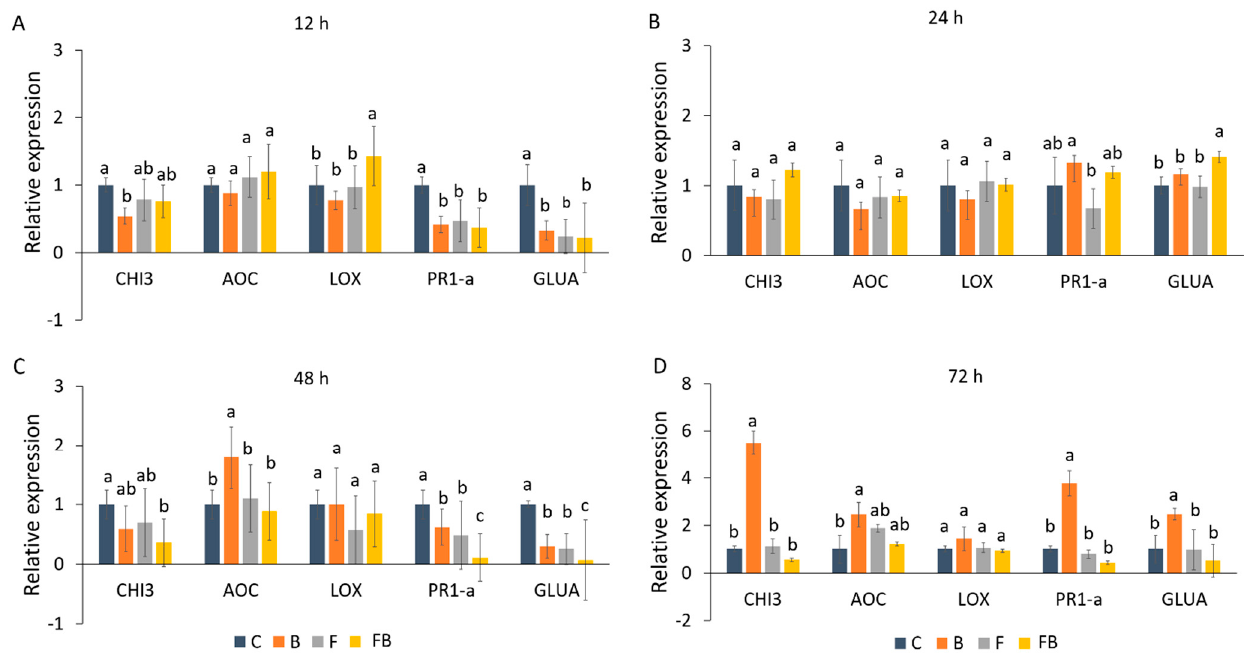
Figure 2. ( A – D ) Relative gene expression analyses of defense-related genes GLUA , CHI3 , PR1-a , LOX , and AOC , in